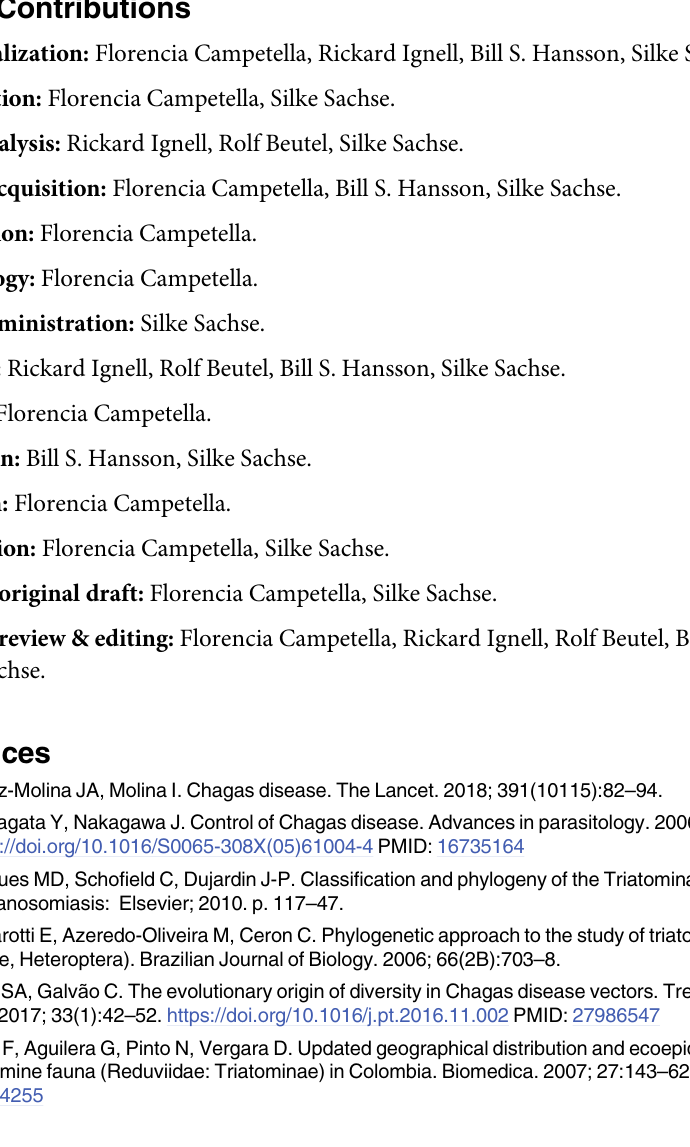
S3 Table. Chemical compounds used in SSR recordings. S4 Table. Euclidean distance for the z-score normalized sensillum types of R . prolixus and R . brethesi